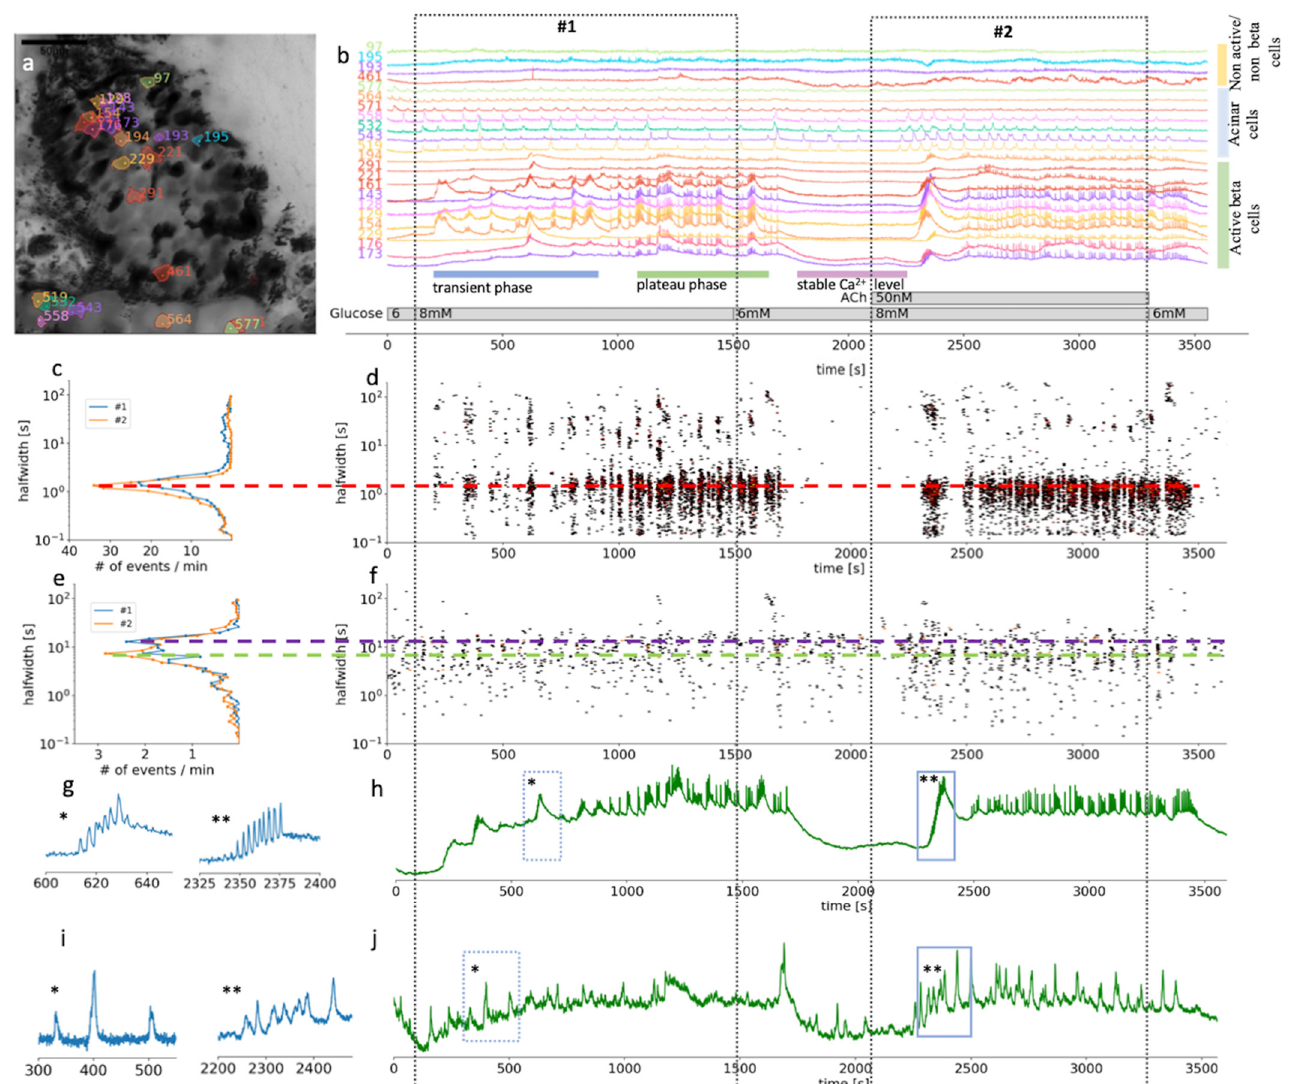
Figure 2. Time scales and heterogeneity of responses of cytosolic Ca 2+ oscillations in mouse beta and acinar cells stimulated with 8 mM glucose or 8 mM glucose plus 50 nM ACh. ( a ) Localization of several beta, acinar and non-active beta on non-beta cells in a pancreas tissue slice. ( b ) Time course of the [Ca 2+ ] c changes in beta, acinar and non-active beta on non-beta cells selected in ( a ). The two dashed rectangles stretching across the panels indicate the periods of stimulation. ( c ) Frequency histogram of the halfwidth durations of the events and ( d ), onset time of the [Ca 2+ ] c events at measured time scales for beta cells ( n = 82). Addition of 50 nM ACh increased the frequency of the [Ca 2+ ] c events, the dominant halfwidth duration stayed unchanged (red dashed line). ( e ) Frequency histogram of the halfwidth durations of the events and ( f ), onset time of the [Ca 2+ ] c events at measured time scales for functional region of acinar cells ( n = 48). Addition of 50 nM ACh increased the frequency of the [Ca 2+ ] c events, the dominant halfwidth length shortened (blue and green dashed line). ( g ) Expanded time traces of an individual ROI (*) from a representative beta cells or an average of all ROIs (**) of active beta cells ( n = 82) as indicated by small blue rectangles in ( h ). ( i ) Expanded time traces of an individual ROI (*) from a representative acinar ROI or an average of all functional regions of acinar cells ROIs (**) (c = 48) as indicated on the temporal profile in ( j ) with small blue rectangles.